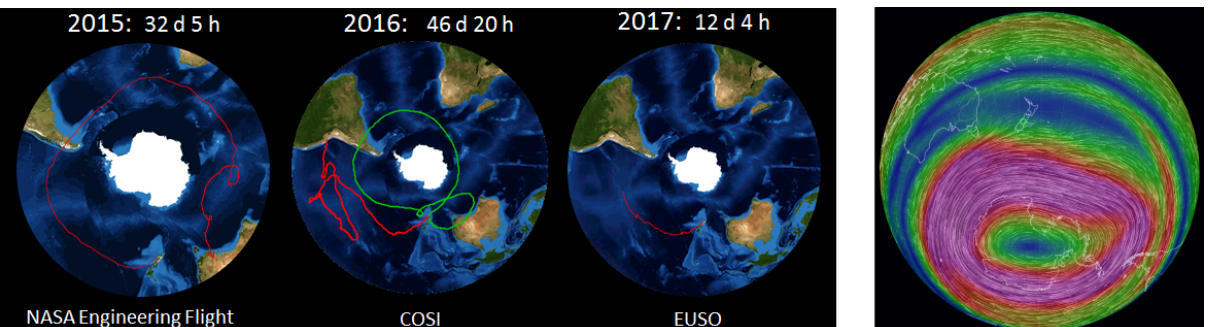
Figure 1: The previous flight trajectories of the NASA super pressure balloons launched from Wanaka, NZ in 2015 (32 d), 2016 (40 d) and 2017 (12 d). The very right panel displays the circular air pattern from 2017 / 04 / 30 (see https: // earth.nullschool.net / #2017 / 04 / 30 / 2300Z / wind / isobaric / 10hPa / orthographic = -177.79,-57.63,40 / loc =